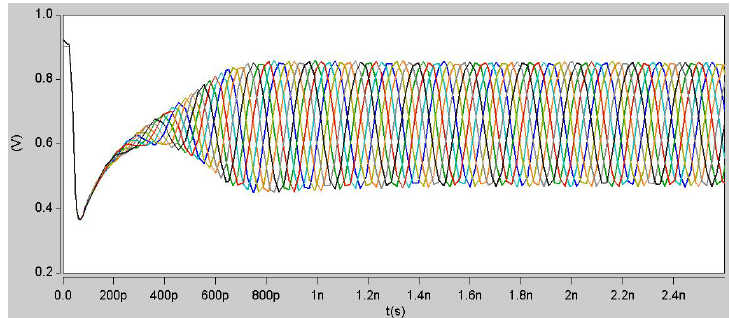
Figure 14. VCO’s output waveforms for a programmed current of 3 mA.